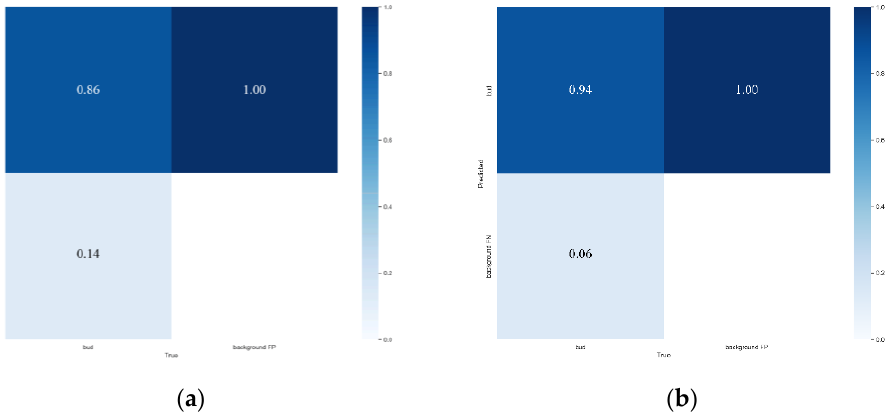
Figure 14. Confusion matrix of YOLOv5m and improved YOLOv5: ( a ) confusion matrix of YOLOv5m; ( b ) confusion matrix of improved YOLOv5.